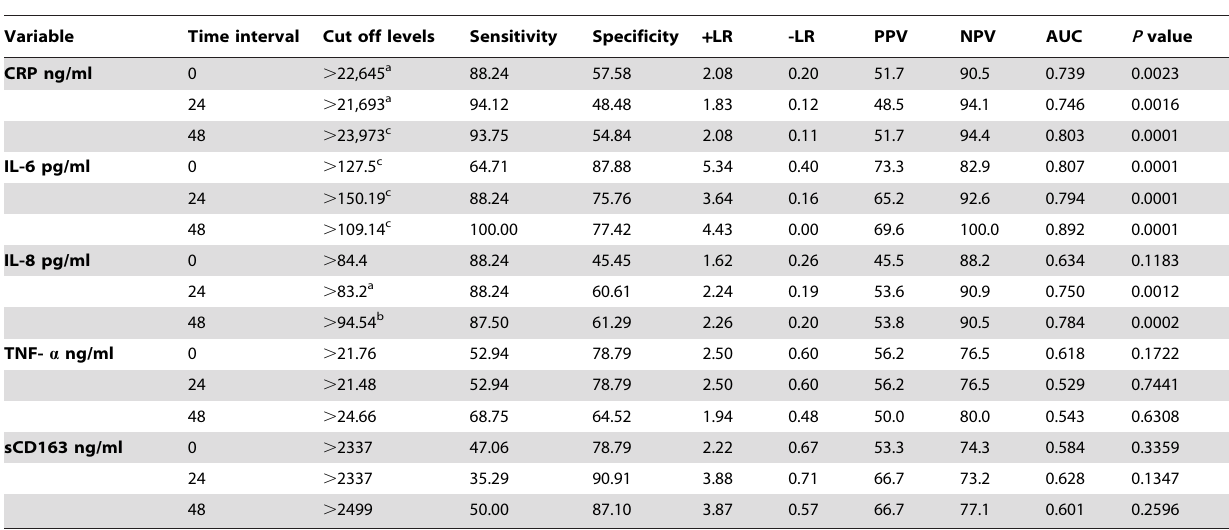
Table 6. Predictive ability of the study parameters to differentiate between the between the survivors and non-survivors of the infected group at different time